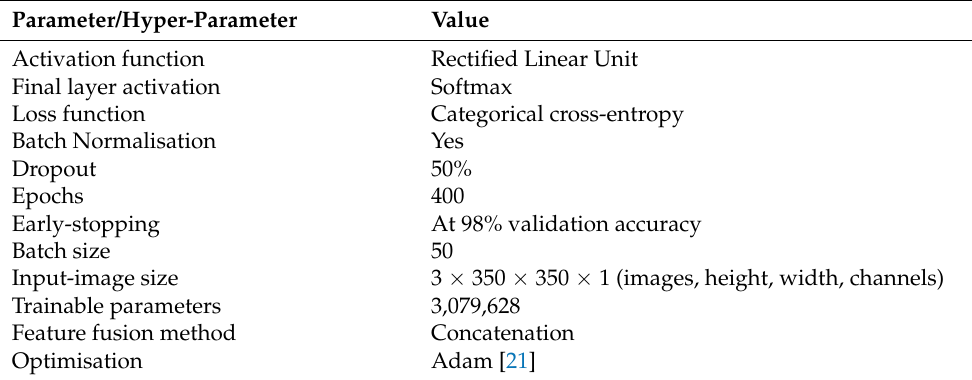
Table 2. Parameters and hyperparameters of ParaNet.